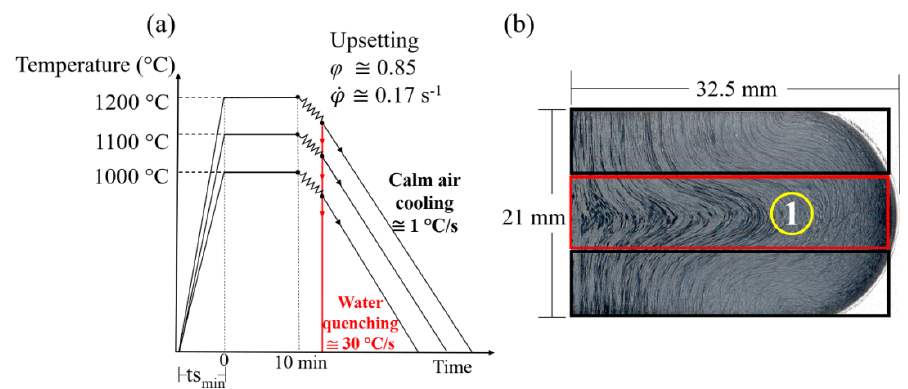
Figure 2. ( a ) Thermomechanical routes. ts min , minimum soaking time. ( b ) Half-section macrograph of the forged sample. The red rectangle indicates the analyzed area. The yellow circle labeled 1 indicates the position from where the micrographs shown in this work were taken.